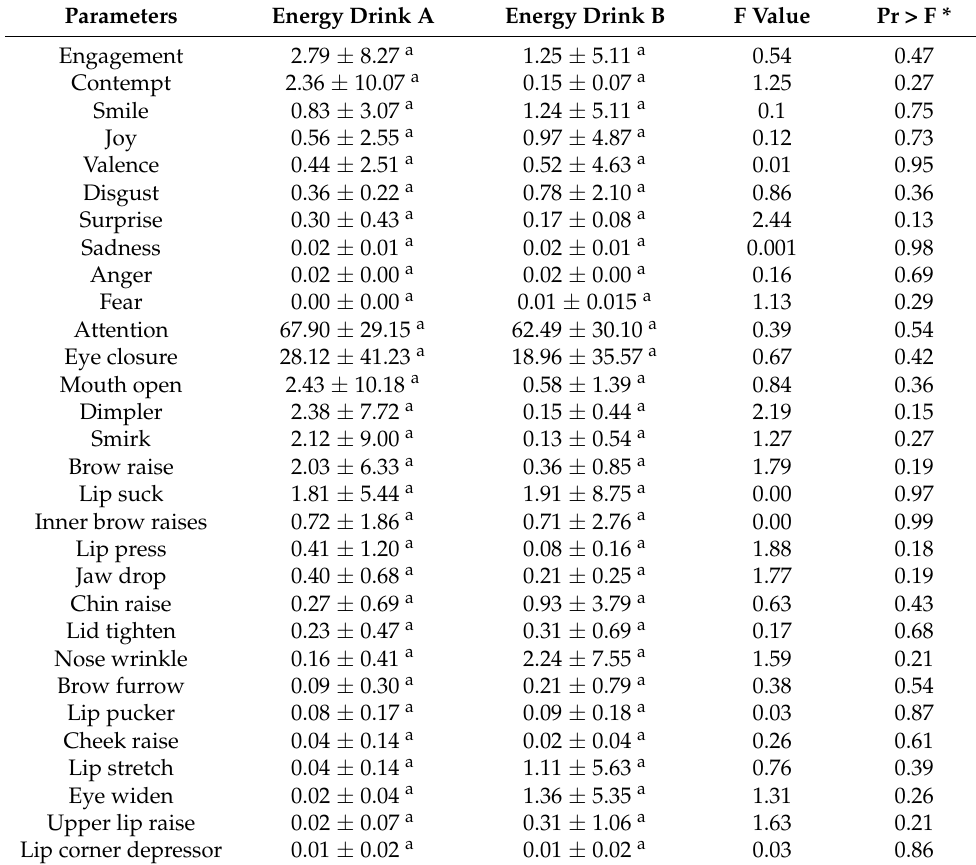
Table 5. Facial expressions and facial features during the tasting of energy drinks A and